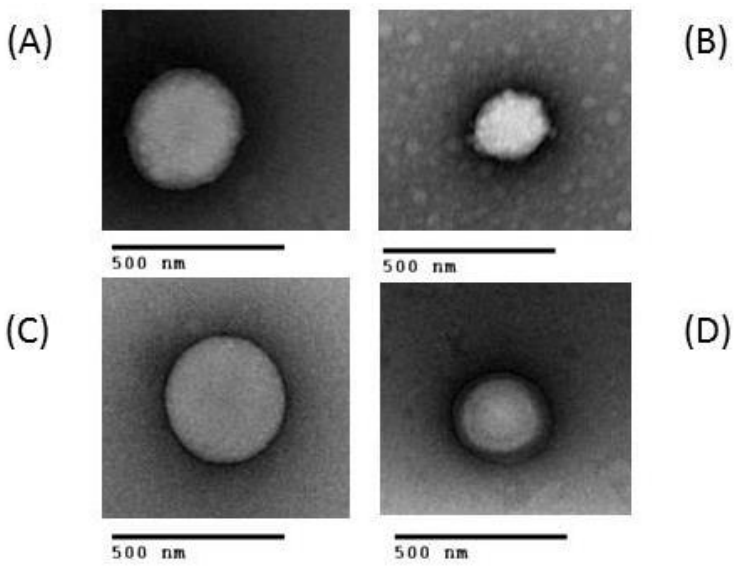
Figure 7. Representative TEM images of CS NPs at N/P ratio of 10 containing: ( A ) LNA1 and ( B ) LNA2 formed with CS Animal; and ( C ) LNA1 and ( D ) LNA2 formed with CS non-animal. All CS NPS were stained with UAR (Uranyl Acetate Replacement Stain).